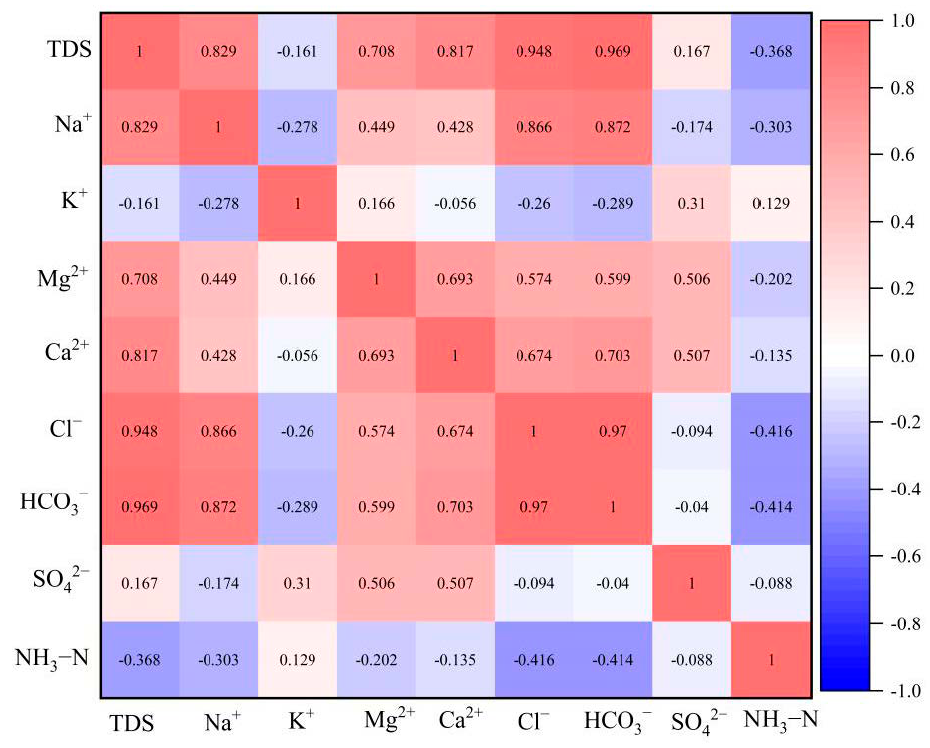
Figure 4. Pearson correlation analysis of major inorganic ions downstream of the landfill.